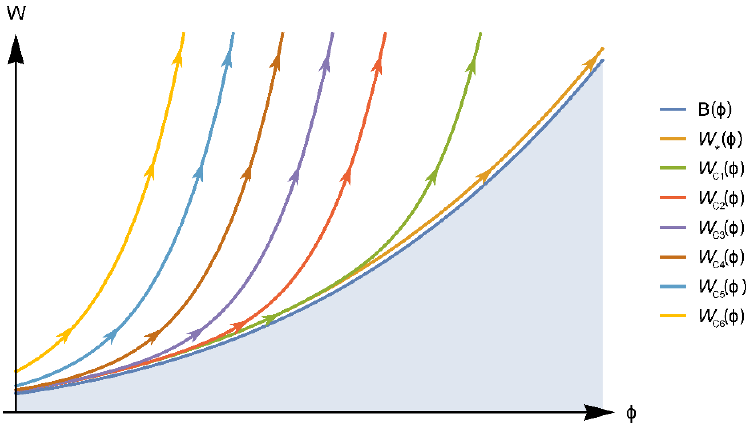
Figure 2 . Schematic view of the solutions of the superpotential equation that reach (cid:30) ! + 1 . The curve W (cid:3) represents the special solution. The curves labeled C 1 through C 6 are di(cid:11)erent curves belonging to the continuous family, and they grow exponentially faster than W (cid:3) . The function B de(cid:12)nes the boundary of the forbidden region as de(cid:12)ned in equation